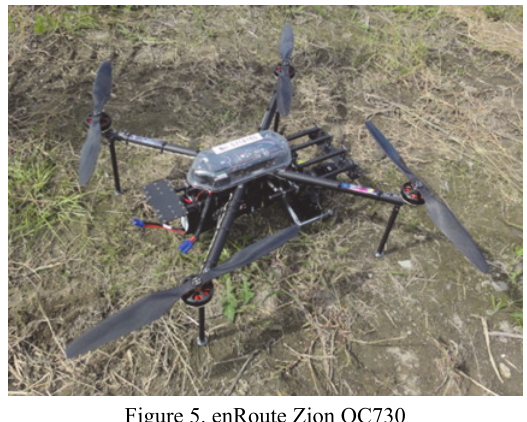
Figure 5. enRoute Zion QC730